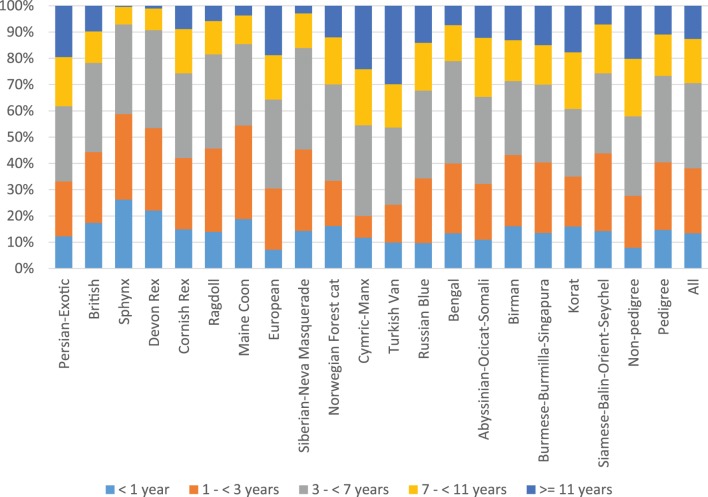
Age distributions of all cats in all breeds.